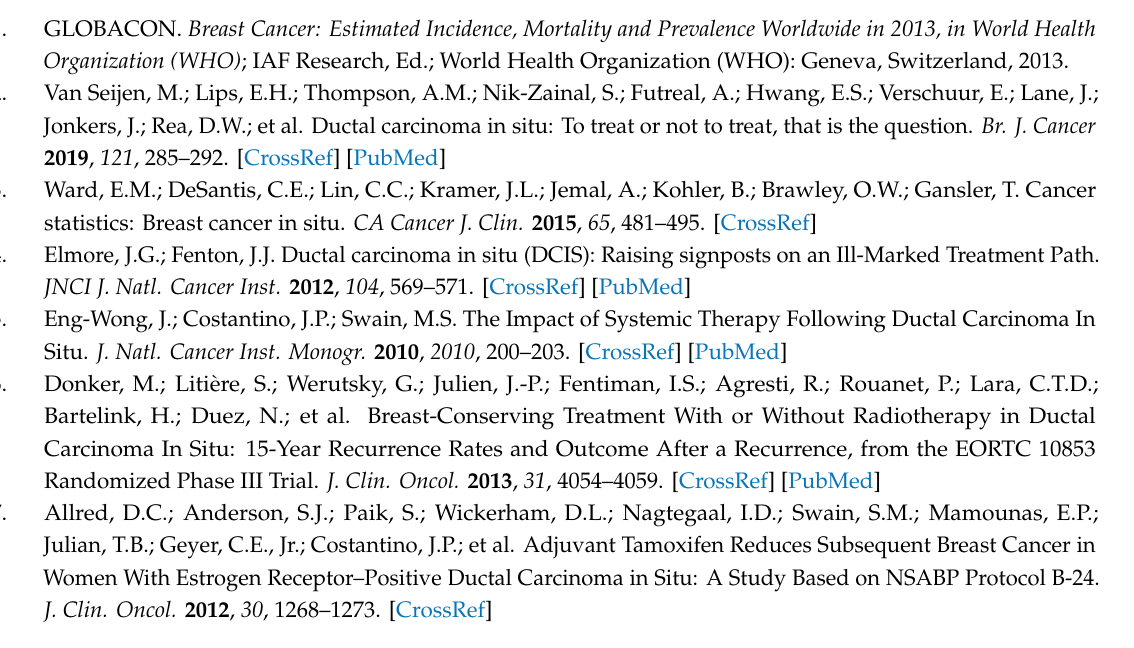
Figure S1. Typical MRM chromatograms of TAMX and 4-OHT in BALB / c mice plasma at three di ff erent concentrations (200, 20 and 2 ng / mL) of TAMX and 4-OHT spiked in the mice plasma compared against blank